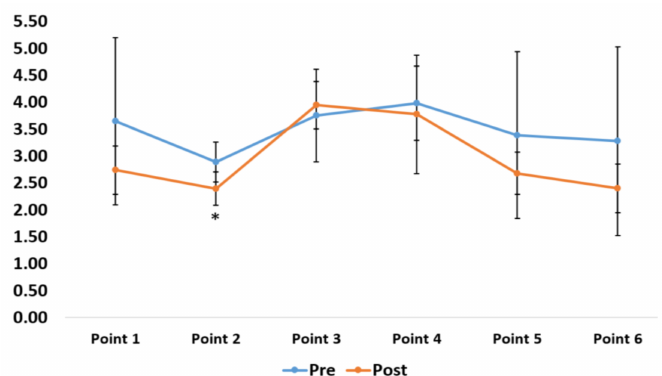
Figure 8. A comparison of the training at various points in the six-point footwork